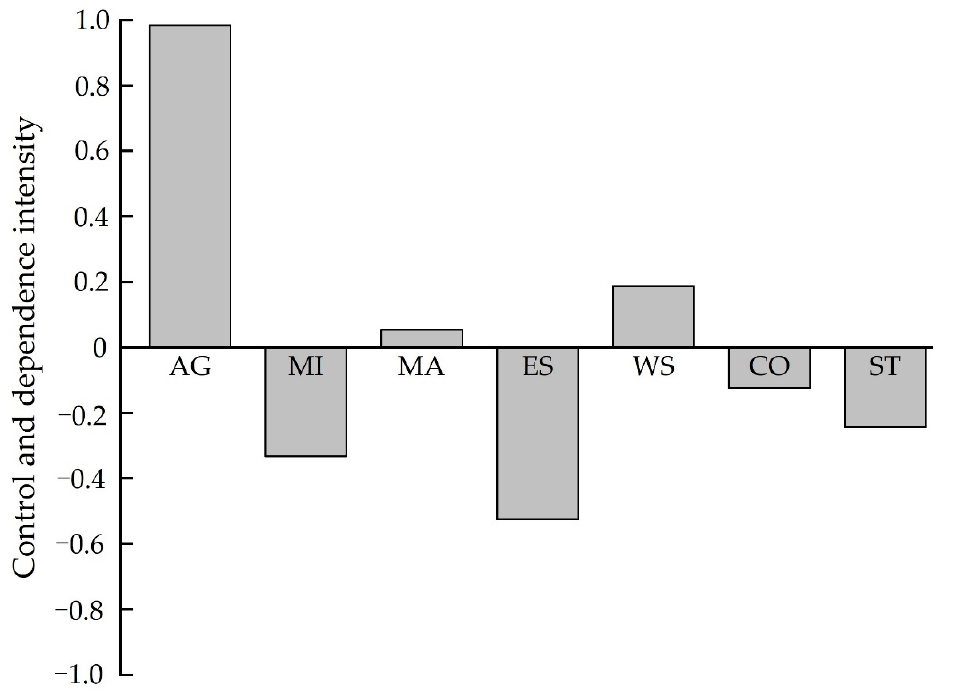
Figure 4. Control and dependence intensity of each compartment in the virtual water system. (Note: AG: agriculture; MI: mining; MA: manufacturing; ES: energy supply; WS: water supply; CO: con- struction; ST: services and transport).